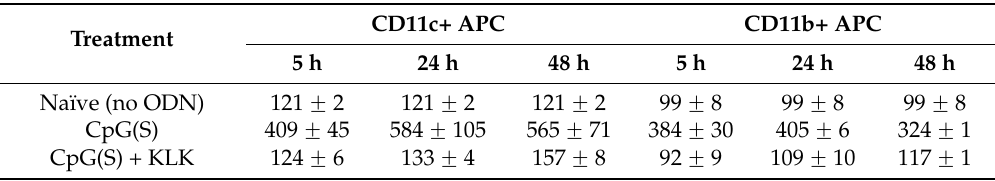
Figure 4. Wild type C57Bl/6 mice ( n = 5/group) were injected with unadjuvanted OVA (10 µ g) or OVA adjuvanted with CpG(S), CpG(O), GpC(S), GpC(O) ODN (4 nmol) alone or in combination with KLK peptides (100 nmol). Spleens were harvested at 24 h post injection and activation of antigen presenting cells was assessed by flow cytometry as indicated in methods. Bars represent the group mean (± SEM). Significant differences between groups is shown by * where *= p < 0.05. Table 3. Uptake of fluorescently labelled CpG(S) ODN into antigen presenting cells (APC) in draining lymph nodes at various times after in vivo delivery by IM injection.